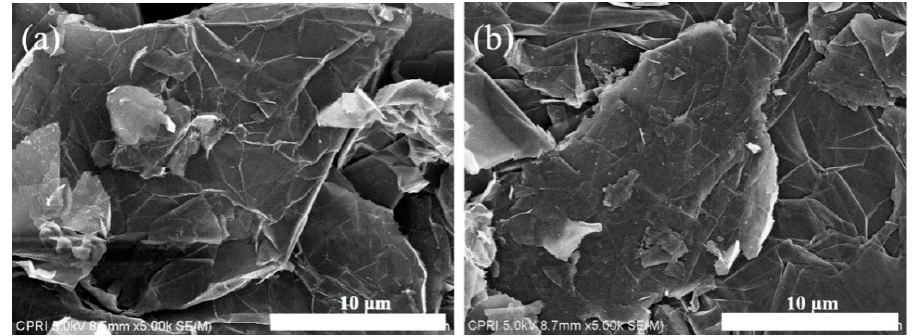
Figure 2. SEM images of ( a ) untreated NTE graphite and ( b ) N-doped NTE graphite.